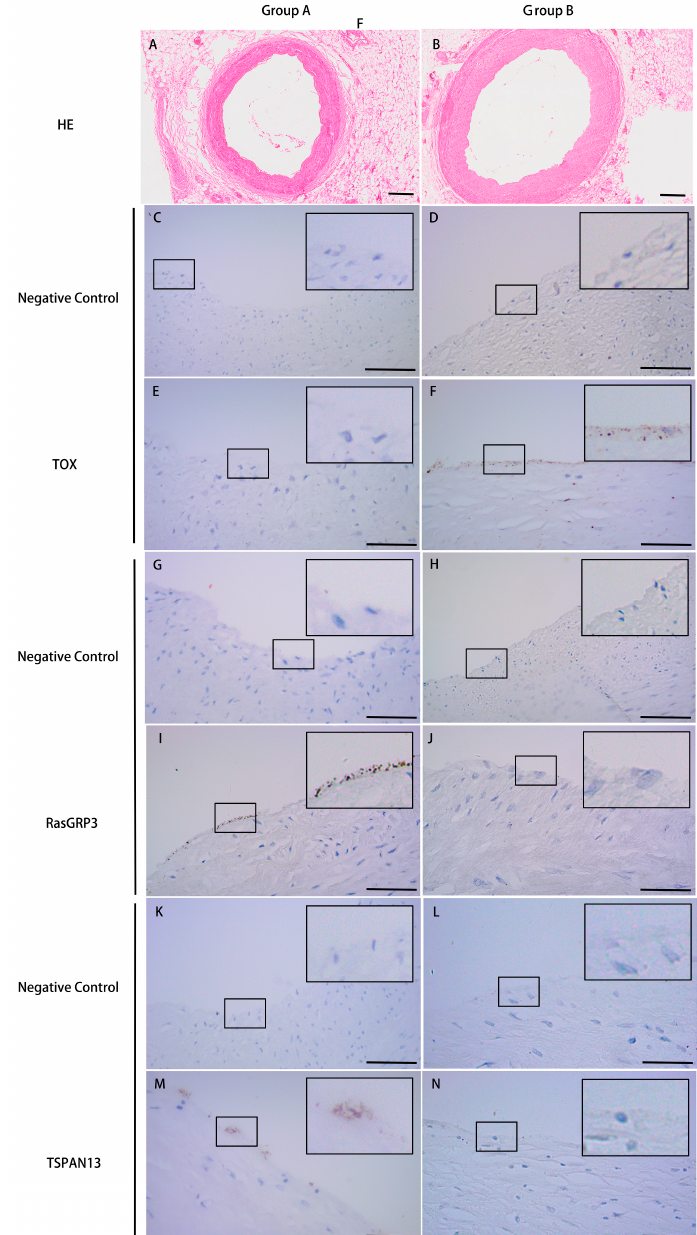
Figure 4. HE staining and validation of the microarray data by IHC. ( A ) Representative figures of HE staining in group A without coronary stenosis. ( B ) Representative figures of HE staining in group B with coronary stenosis less than 25%. ( C ) Negative control of TOX in group A. ( D ) Negative control of TOX in group B. ( E ) Representative IHC figures of TOX in group A. ( F ) Representative IHC figures of TOX in group B. Compared to group A, the expression of TOX in group B was significantly upregulated ( p = 0.031). ( G ) Negative control of RasGRP3 in group A. ( H ) Negative control of RasGRP3 in group B. ( I ) Representative IHC figures of RasGRP3 in group A. ( J ) Representative IHC figures of RasGRP3 in group B. Compared to group A, the expression of RasGRP3 in group B was significantly downregulated ( p = 0.032). ( K ) Negative control of TSPAN13 in group A. ( L ) Negative control of TSPAN13 in group B. ( M ) Representative IHC figures of TSPAN13 in group A. ( N ) Repre- sentative IHC figures of TSPAN13 in group B. Compared to group A, the expression of TSPAN13 in group B was significantly downregulated ( p = 0.046). Magnification of HE: 200 × . Magnification of IHC: 400 × . bar = 50 µ